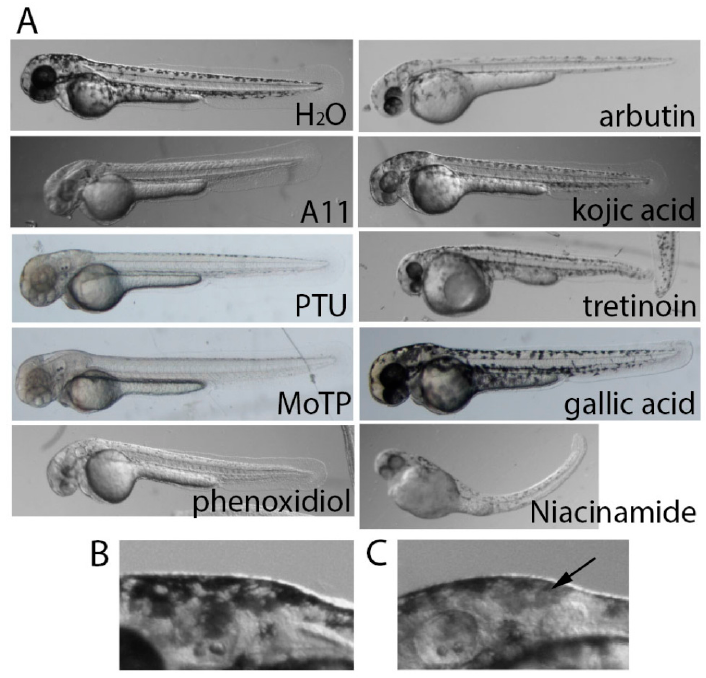
Figure 3. Comparison between A11 and known skin-lightening compounds. ( A ) Zebrafish embryos were treated with different skin-lightening compounds to show different degrees of pigment inhibition. A11 (10 μ M), PTU (0.003%), MoTP (10 μ M), and phenoxidiol (10 μ M) all exhibited strong pigment inhibition, but ® -arbutin (100 mM), kojic acid (10 mM), tretinoin (1%), gallic acid (1 mM), and niacinamide (1%) showed weaker inhibition. Some skin-lightening compounds apparently caused strong toxicity to developing embryos, body curvature by niacinamide and eye and tail defects by tretinoin. High magnification of the head area of embryos in H 2 O ( B ) and kojic acid ( C ) are shown to display the lighter pigment in melanocytes (arrow) caused by kojic acid.